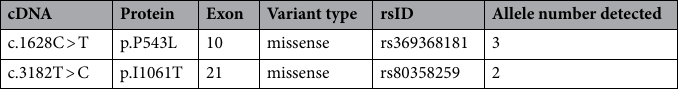
Table 1. NP-C variants classified as pathogenic.